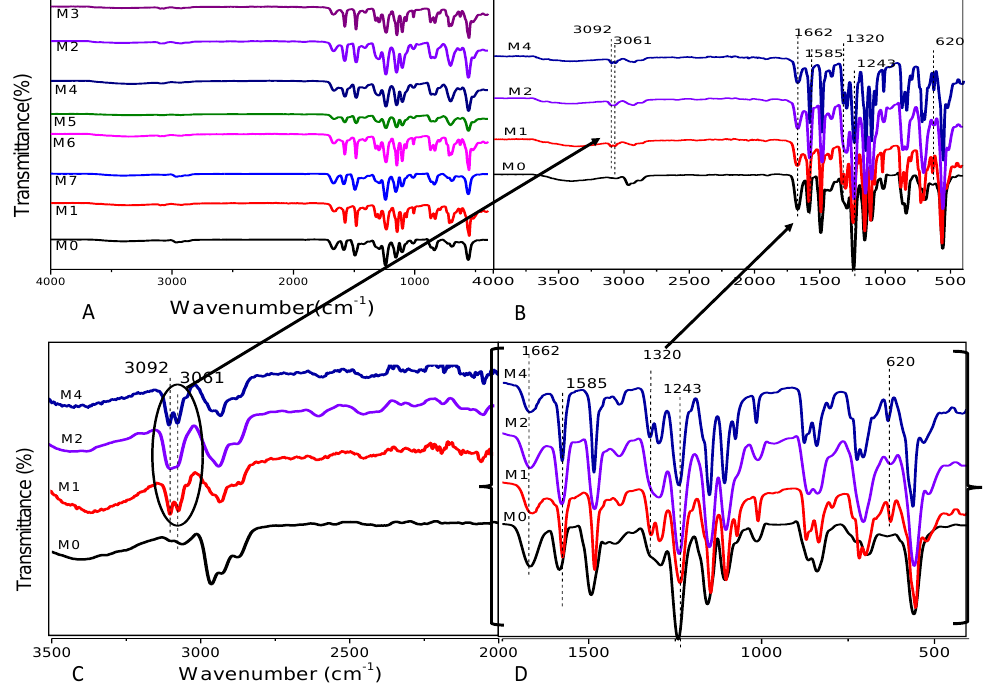
Figure 8. FTIR spectra of ( A ) M0-M7 composite membranes, ( B ), is the FTIR spectra of M0, M1, M2 and M4 whilst ( C , D ) are the expansions of the indicated regions of the composite membranes.